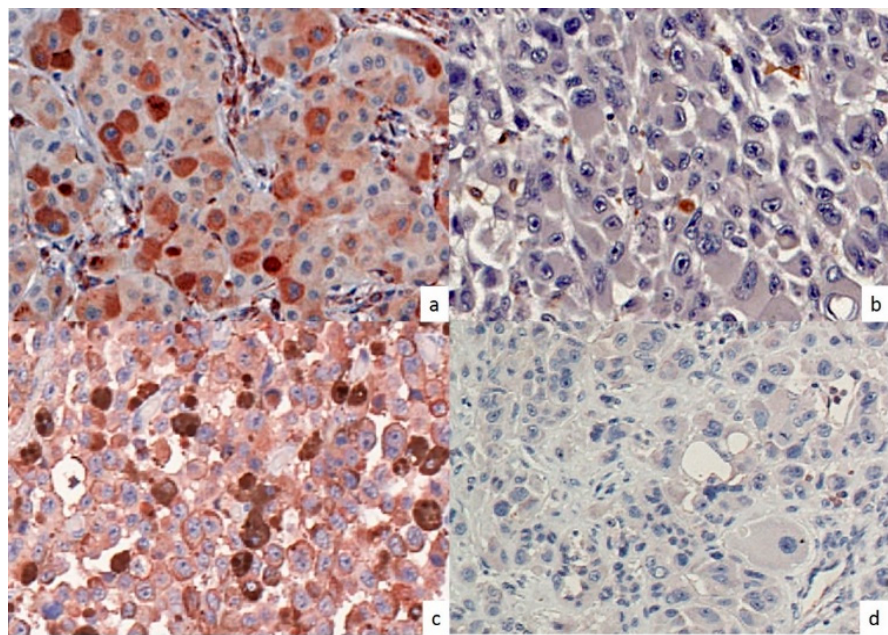
Figure 6. Tumor CD74 and NT expression characteristics by immunohistochemical analyses. Stage IV melanoma tissues from patients were immunostained for CD74 and NT. As published previously (10), both intensity and percentage of positive cells were quantified and protein expression associating with overall survival (OS) in this retrospective tissue microarray. Representative tumor CD74 positive ( a ) and CD74 negative ( b ), NT positive ( c ) and NT negative ( d ) specimens are shown (400 × magnification). Both positive samples are scored as 3 for both intensity (intense staining) and number ( > 75% of cells stained) and negative samples are 0 for both intensity (no staining) and number ( < 5% of cells